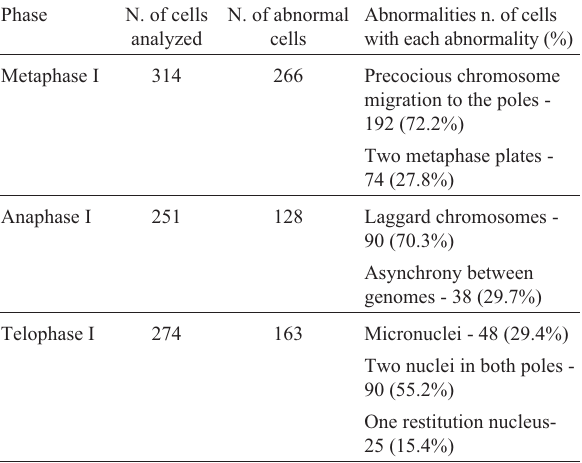
Table 1 - Meiotic abnormalities recorded in the hybrid, related to chromo- some segregation and abnormal genome orientation in the metaphase